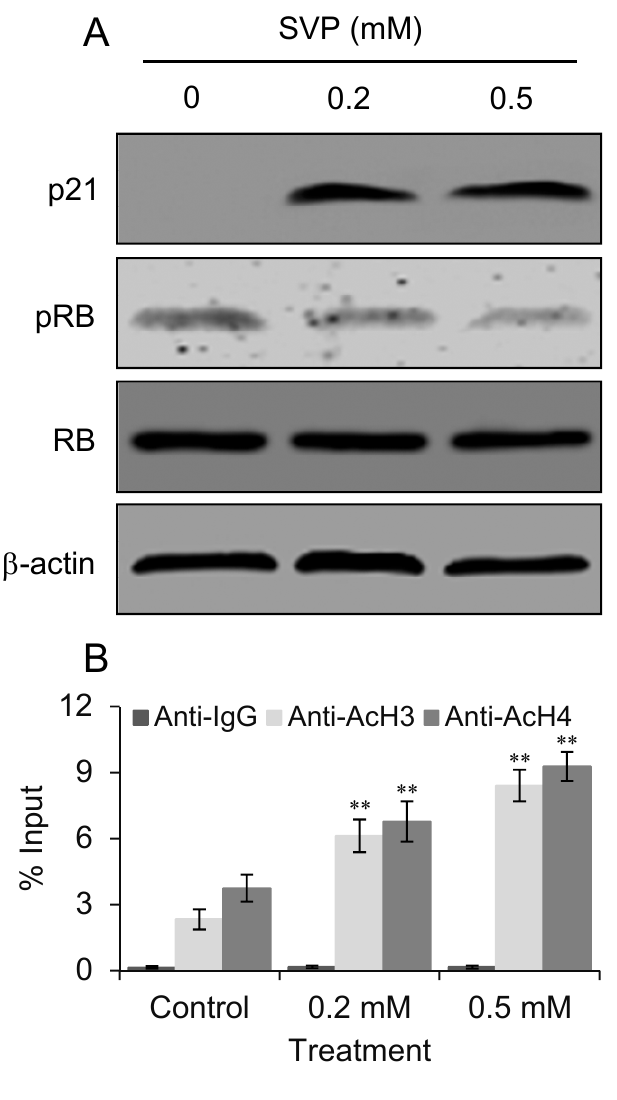
Figure 7. Effects of SVP on expression of cell senescence regulatory genes in Bel-7404 cells. ( A ) Bel-7404 cells were treated with 0.2 and 0.5 mM of SVP for 120h, and subjected to western blots using antibody against p21, pRB and RB. β -actin was used as a loading control. ( B ) ChIP-qPCR analysis using AcH3 and AcH4 antibody or control IgG. Precipitated genomic DNA was amplified by qPCR and expressed as percentage of the total input genomic DNA. The result of three independent experiments was shown as mean ± S.D. ** p < 0.01, versus control